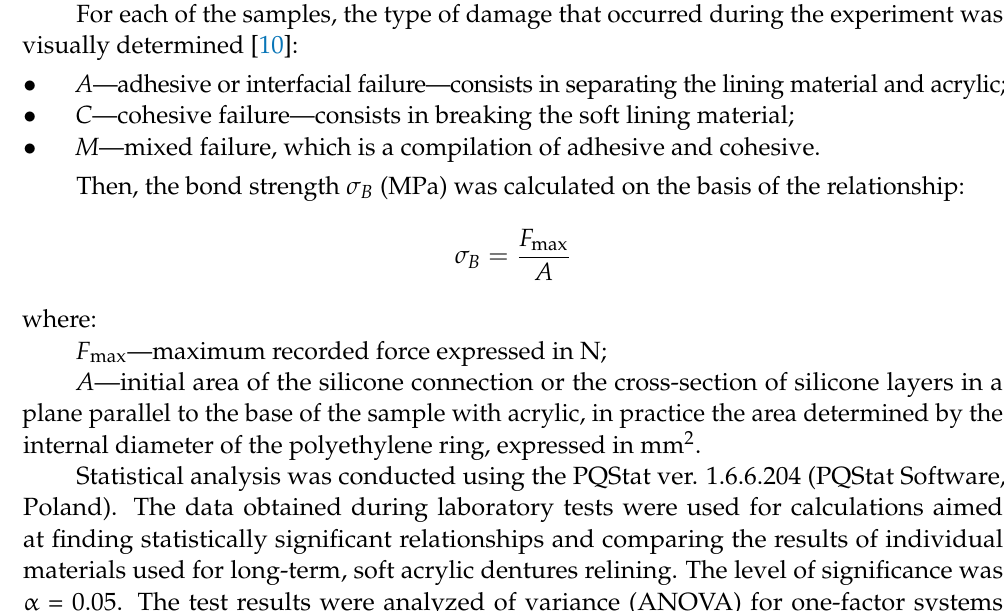
Figure 1. A sample during the test of the strength of the connection between the soft lining material and the acrylic resin.